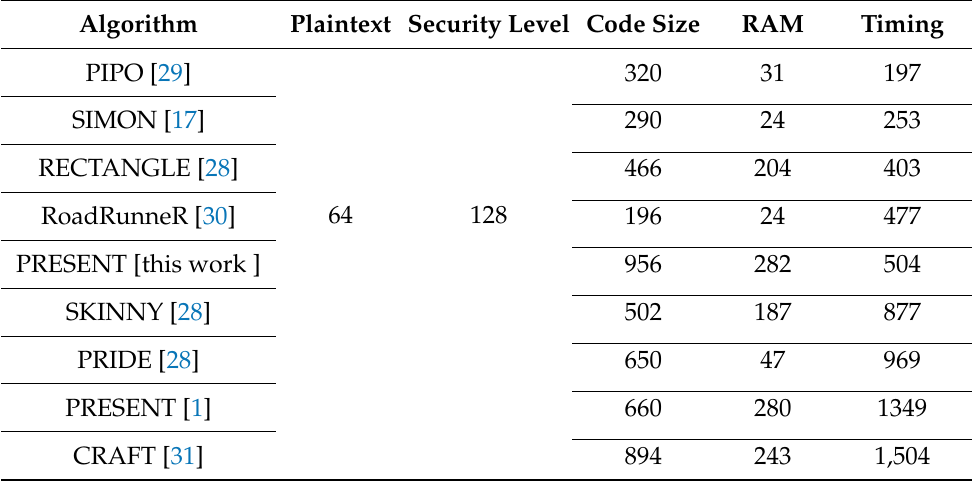
Table 3. Comparison of other implementations on target embedded processors (AVR) in terms of timing (cycles per byte), RAM (bytes), and code size